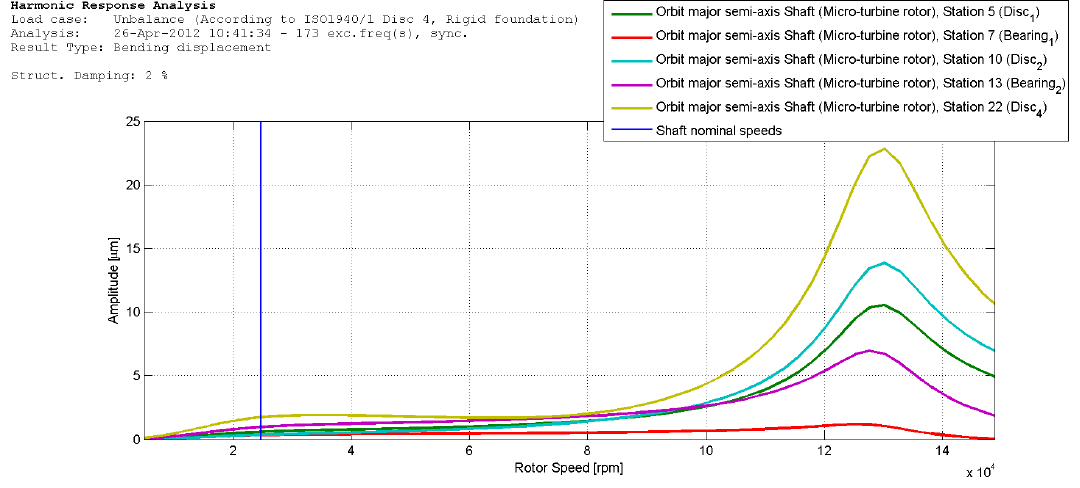
Figure 16: Amplitude of the rotor vibration with rigid bearing